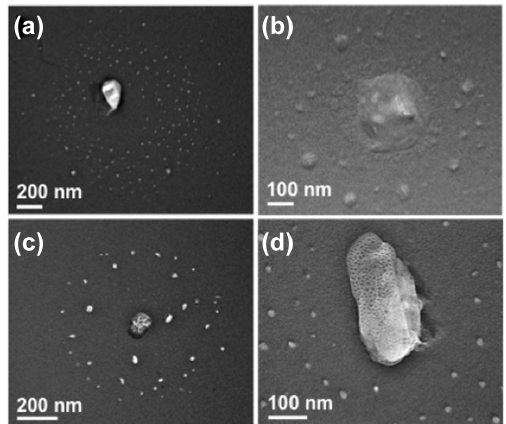
Figure 10. Examples for halo particles observed with TEM. (a) A central “aggregate” particle surrounded by satellite particles of sul- furic acid and a smaller amount of methane sulfonic acid. (b) A central particle of “aggregate with film”, surrounded by satellite particles of sulfuric acid and methane sulfonic acid. (c) A central particle of ammonium sulfate, satellite particles formed by methane sulfonic acid, probably mixed with sulfuric acid. (d) A central parti- cle of degenerated gel, surrounded by methane sulfonic acid mixed with sulfuric